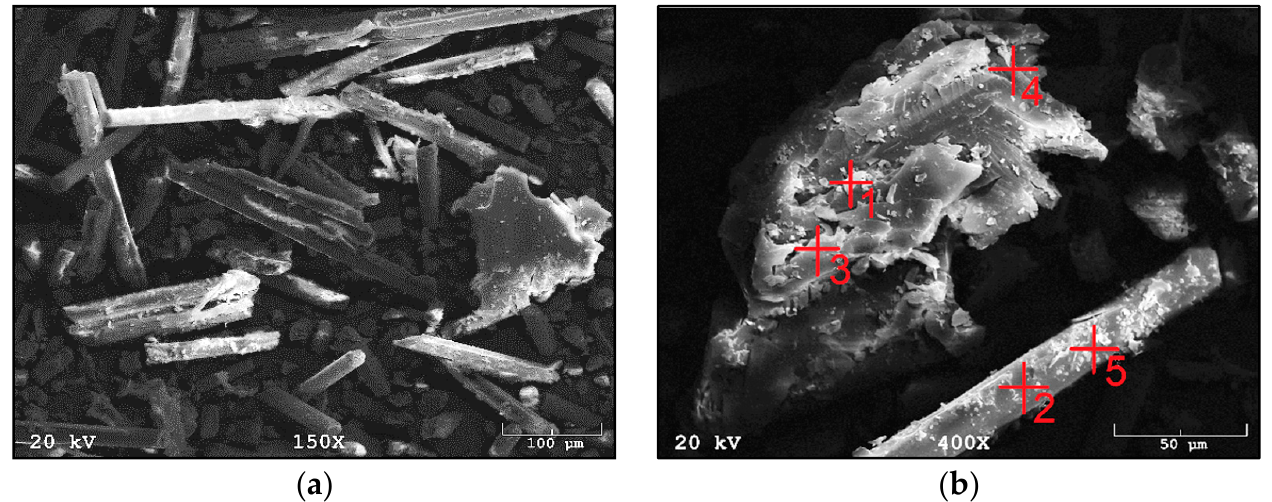
Materials 2021 , 14 , x FOR PEER REVIEW Figure 7. SEM images of fraction III from wind turbines: ( a ) in 150× magnification; ( b ) in 450× magnification. Figure 7. SEM images of fraction III from wind turbines: ( a ) in 150 × magnification; ( b ) in 450 × magnification.